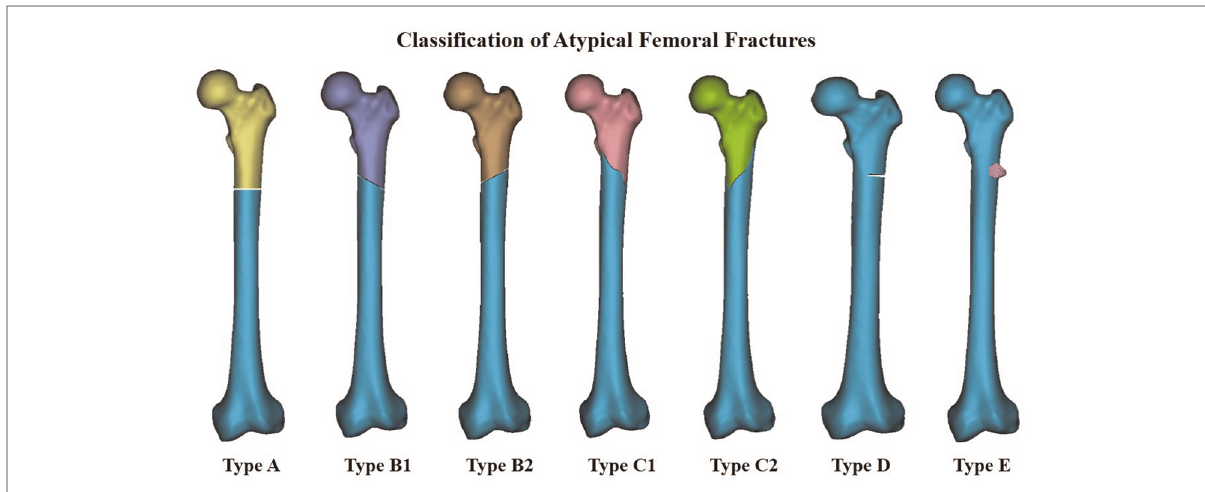
FIGURE 3 Classi fi cation of atypical femoral fractures; Type A implies transverse fracture, Type B implies short oblique fracture (which itself has2 subtypes), Type C implies spiral fracture associated with a medial spike (which itself has 2 subtypes), Type D implies incomplete fractures involving only the lateral cortex, Type E implies localized periosteal reaction in the lateral cortex.